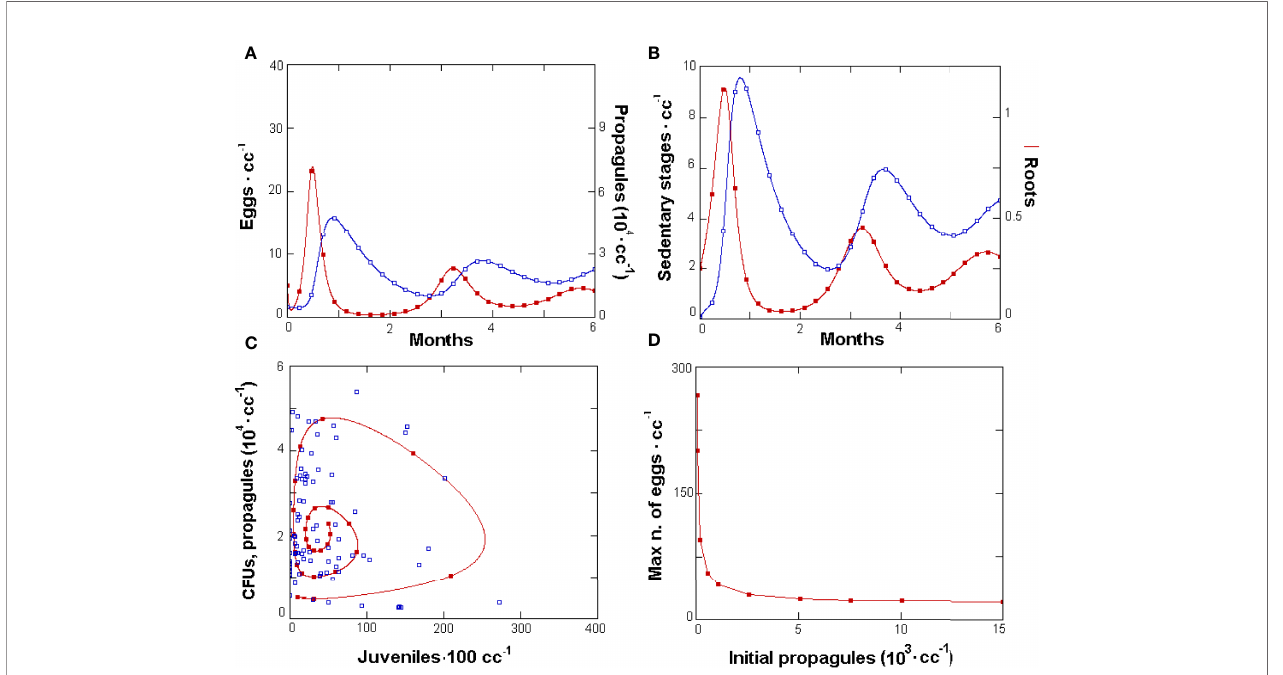
FIGURE 2 | GPNR-simulated dynamics of Meloidogyne incognita , Pochonia chlamydosporia , and roots. (A) Six-month population dynamics of M. incognita eggs ( fi lled symbols) and parasitic fungus propagules and (B) roots ( fi lled symbols) and nematode sedentary stages. Data were produced with initial P. chlamydosporia densities of 5 · 10 3 propagules · cc soil -1 . GPNR validation with observed data (C) : phases space plot of simulated propagule numbers ( fi lled symbols) resulting from the model cycle, and of observed mean colony-forming units from soil and roots · cc -1 vs . simulated and observed J2 · 100 cc soil -1 (empty squares). The starting values for other variables were as follows: 5 eggs · cc soil -1 , 0.1 adults · cc soil -1 , 0.1 J2 · cc soil -1 , and 0.25 g roots · cc soil -1 . (D) Effect of increasing initial fungus densities on the maximum number of eggs · cc soil -1 observed in the